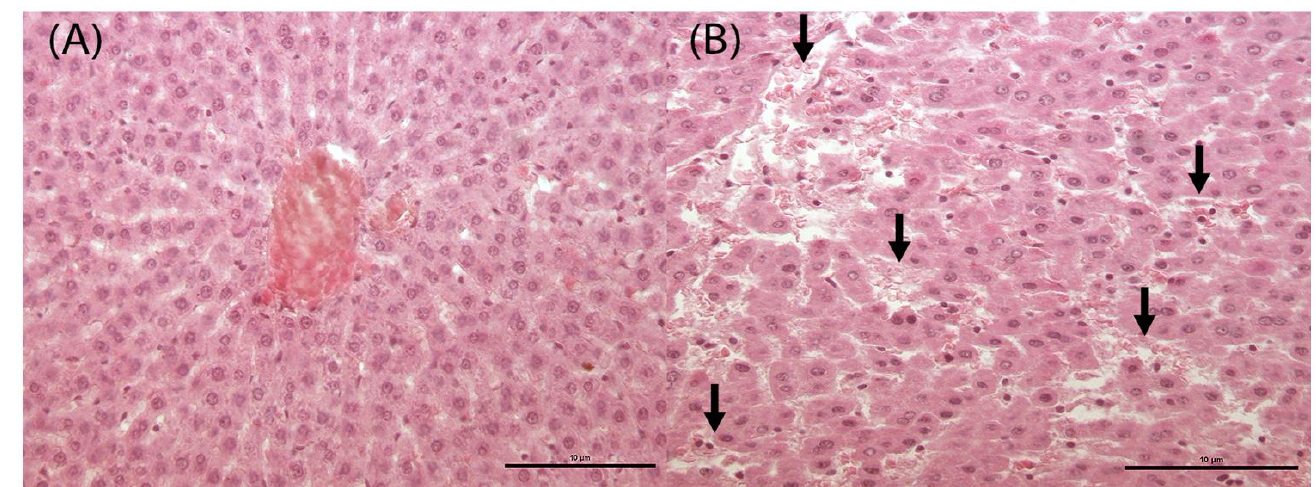
Figure 8. Liver of female rats subcutaneously treated two times a week, for 2 weeks with 0—sesame oil Panel ( A ) and 2.05 mg of testosterone enanthate Panel ( B ). Black arrows indicate sinusoidal dilatation (enlargement of the hepatic capillaries). Bar 10 µ m (original magnification. 20 × ; haematoxylin and eosin stain). Table 4. Histopathological endpoints in target organs of female rats subcutaneously treated with different doses of testosterone enanthate two times a week, for 2 weeks: CF 0 — sesame oil, D1F 0.45,